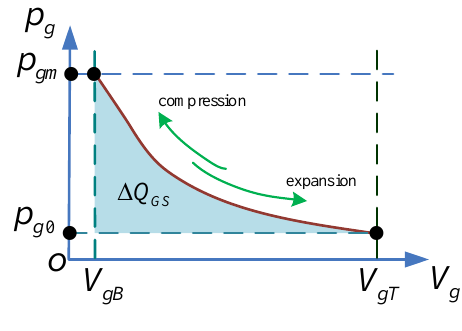
Figure 7. P-V diagram of GS.